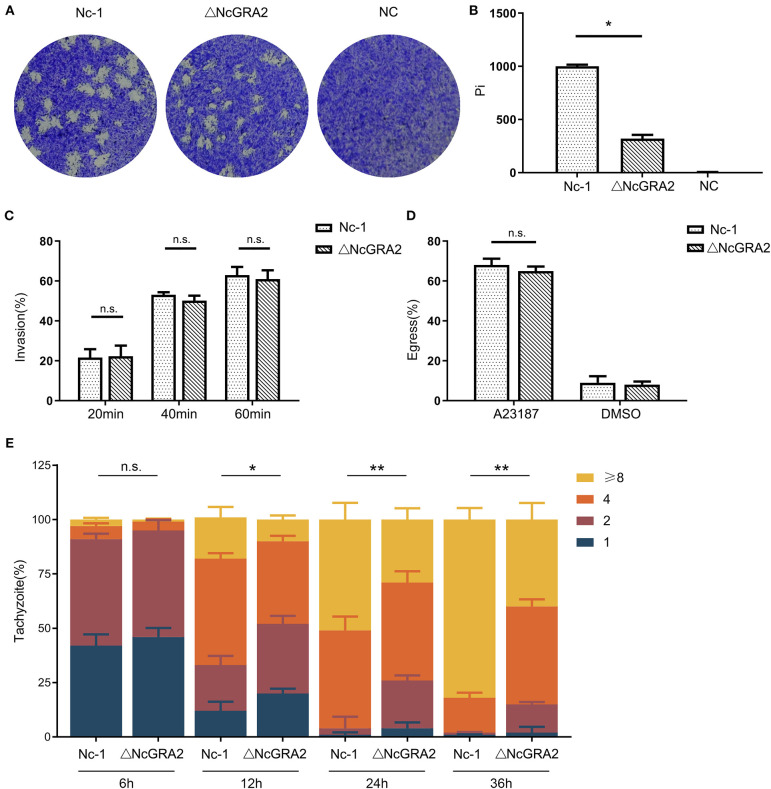
Disruption of the NcGRA2 gene adversely affects virulence in vitro. (A,B) Plaque assays were carried out by inoculation of parasites onto HFF cells previously coated on six-well plates (80–120 tachyzoites per well), followed by culturing for 7 days. The Nc-1 group was used as a positive control, and the NC group was used as a negative control. After staining with crystal violet, the cells were imaged, and then pixels of plaques (Pi) were measured by randomly selecting no fewer than 20 plaques and counting with pixel points in Photoshop CS5 software. (C) Invasion assays were conducted through inoculation of the Nc-1 strain and ΔNcGRA2 strain with an infection dose of 1 × 105 tachyzoites/well onto HFF cells coated on coverslips in 6-well plates and then culturing for the indicated time. Immunofluorescence assays with anti-NcSRS22A and anti-NcGRA2 antibodies were carried out to label the total parasites and extracellular parasites, and then the invasion percentage was calculated. (D) Egress assays were performed by inoculation of the Nc-1 strain and ΔNcGRA2 strain onto HFF cells coated on coverslips in six-well plates (1 × 105 tachyzoites/well) and culturing for 48 h. After stimulation with the Ca2+ ionophore A23187, immunofluorescence assays with anti-NcGRA2 antibodies were conducted, and the egress percentage was measured from 100 randomly selected vacuoles. The dilution buffer, DMSO, was used as a negative control. (E) Intracellular parasite replication assays were measured by pretreatment of HFF cells with the Nc-1 strain and ΔNcGRA2 strain (1 × 106 tachyzoites/well) for 4 h and then culturing for the indicated time. Immunofluorescence assays with anti-NcSRS22A antibodies were performed, and parasite replication was determined by 100 randomly selected vacuoles. *p < 0.05, **p < 0.01, and n.s. represents no significance vs. the Nc-1 group.